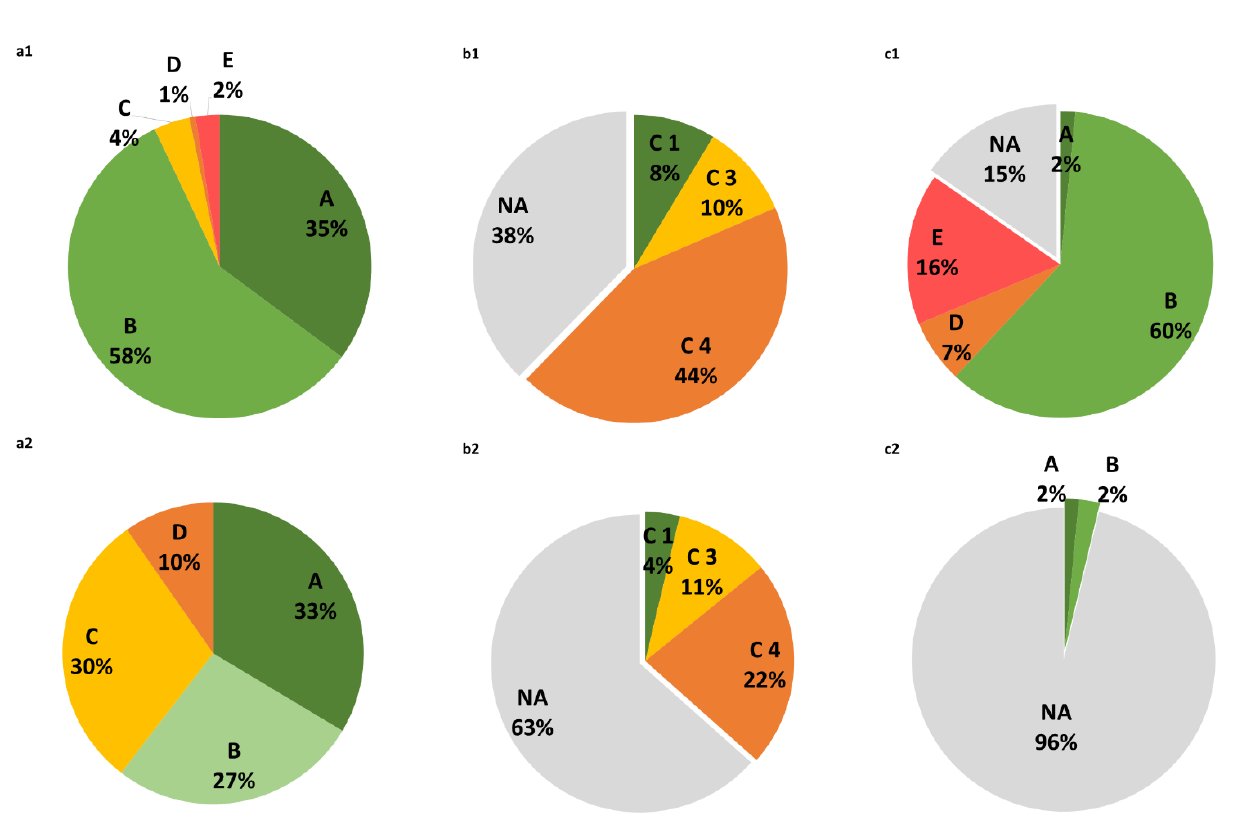
Figure 4. Pie charts of the distribution of foods into the categories set by Nutri-Score, NOVA, and Eco-Score. Nutri-Score ( a1 , a2 ), NOVA index ( b1 , b2 ), and ECO-score ( c1 , c2 ) of PB “milk alternatives” ( a1 , b1 , c1 ) and PB foods ( a2 , b2 , c2 ). The percentage of products with a certain score is indicated. NA: not available.